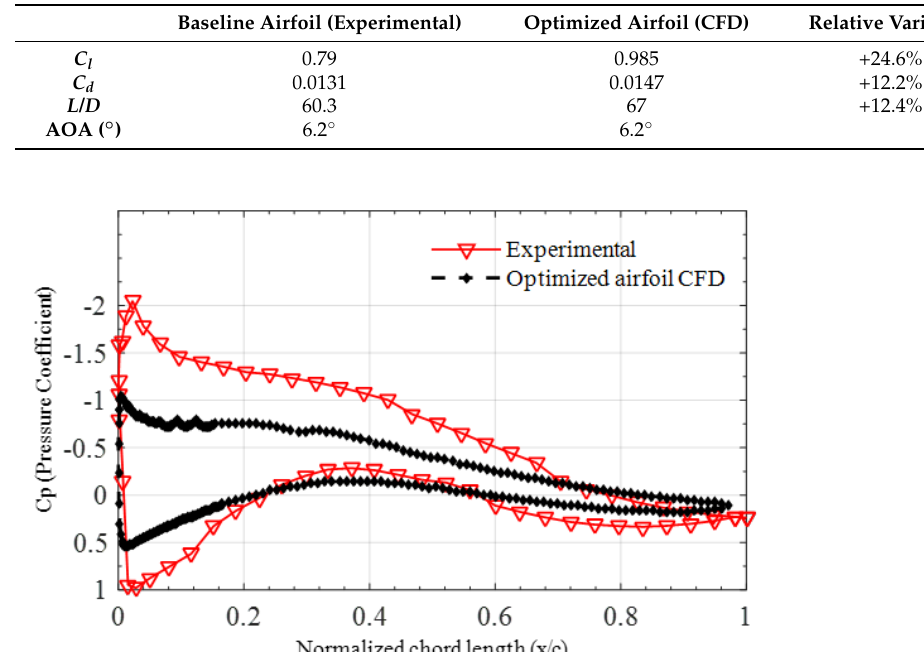
Figure 14. Pressure distribution curve plot between the experimental and CFD S809 airfoils. Table 7. Comparison of simulation data of the original and optimized airfoils by CFD (NREL